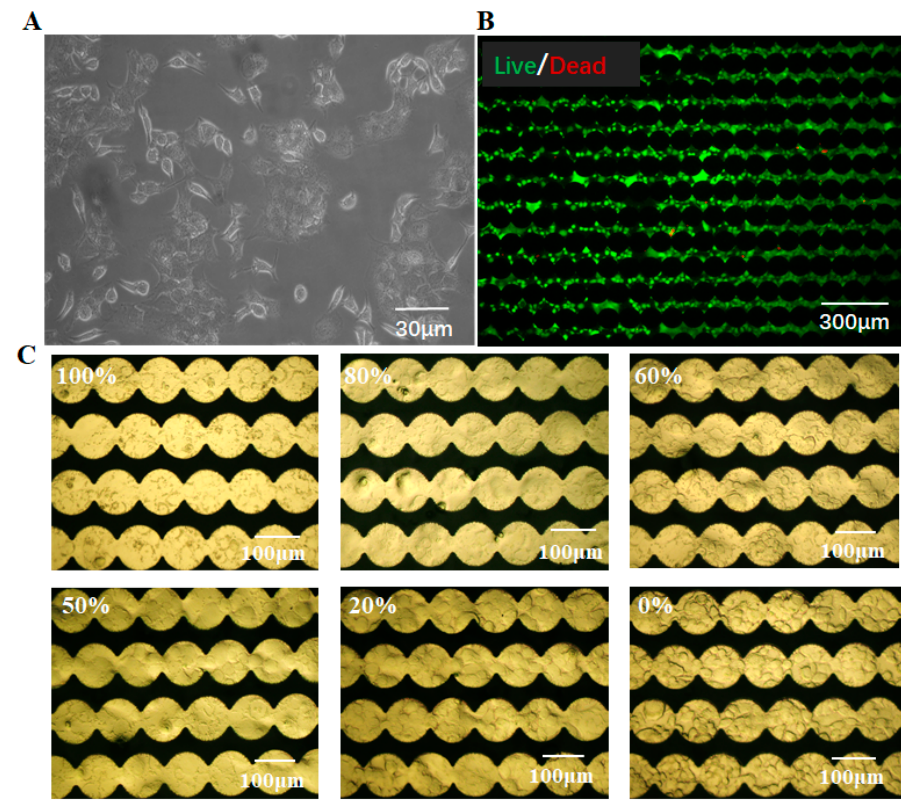
Figure 2. Caco-2 cells and SH − SY5Y cells co − culture. ( A ) Micrograph of co − culture containing Caco − 2 cells and SH − SY5Y cells in T25 culture flask; ( B ) Live/dead staining showed that Caco − 2 cells and SH-SY5Y cells grew well on ECIS chip; and ( C ) Different proportions of Caco − 2 cells and SH − SY5Y cells on ECIS sensor chip .